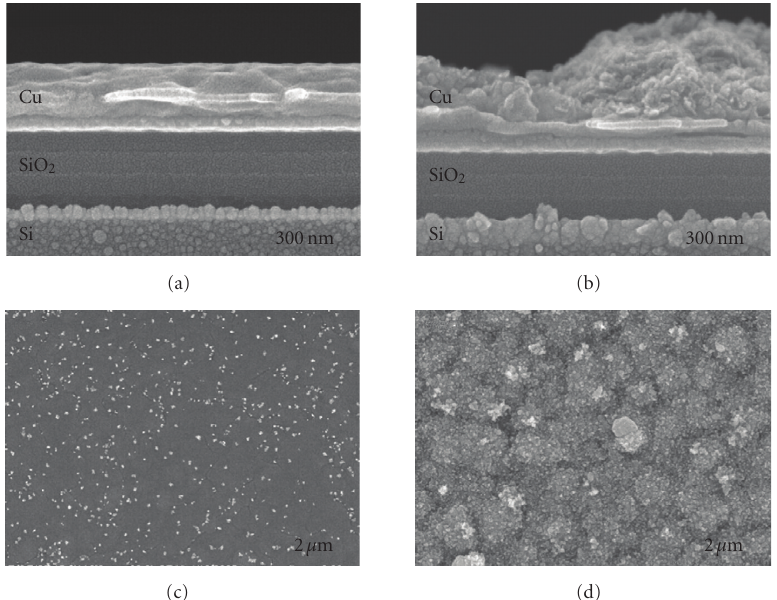
Figure 4: SEM cross-section images of (a) fresh Cu substrate and (b) NH 3 -treated Cu substrate. The corresponding surface morphologies of (c) fresh Cu substrate and (d) NH 3 -treated Cu substrate.